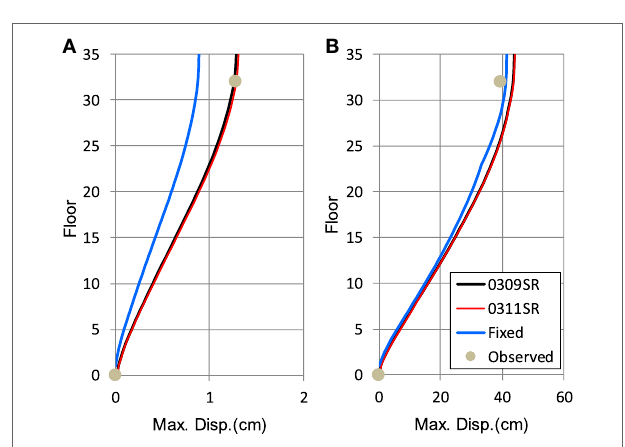
FigUre 12 | Comparison of soil spring effects for (a) the 3/9 pre-shock and (B) the 3/11 main shock (N–S